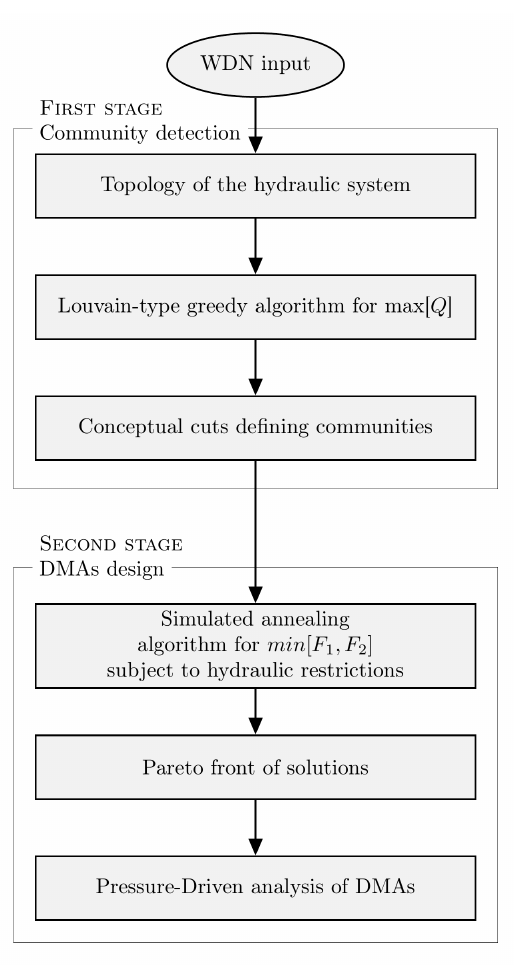
Figure 2. Conceptual flowchart of the